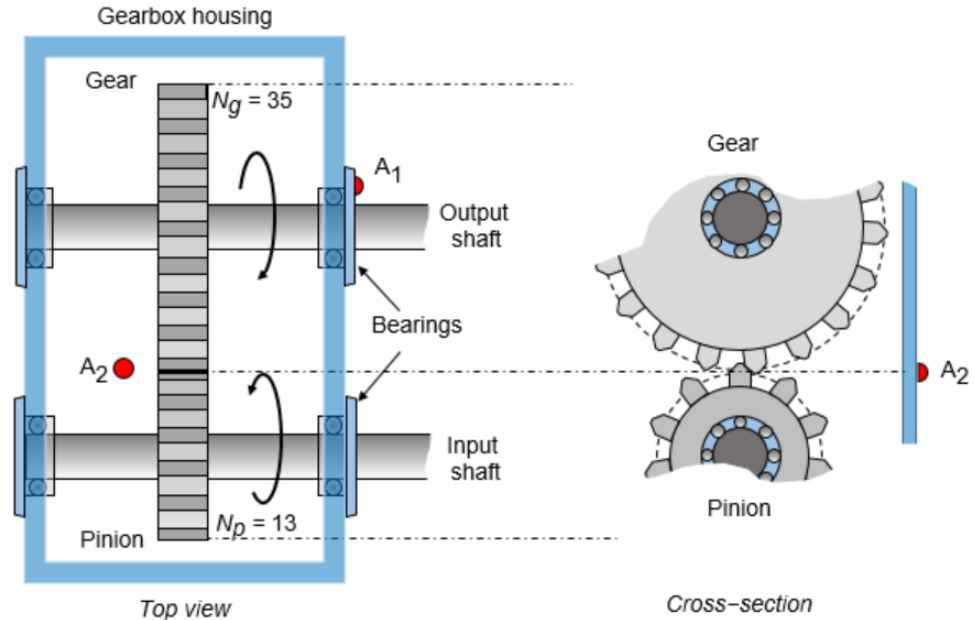
Figure 2. General scheme of the gearbox.